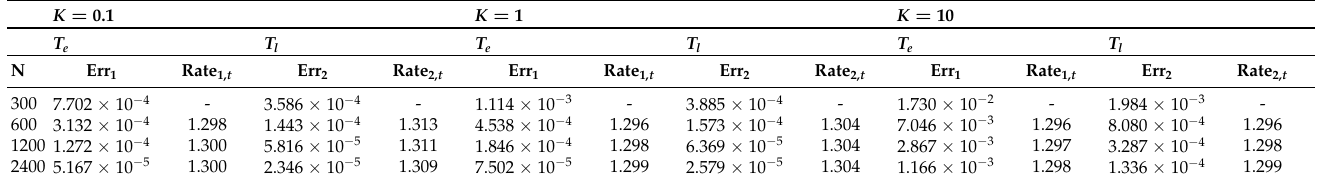
Table 2. Temporal convergence rate when M = 500 and ( α , β ) = ( 0.7,0.3 ) for Example 1.